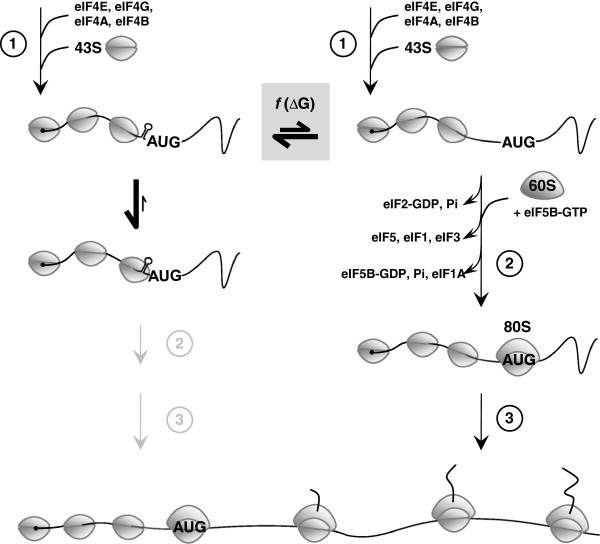
Effects of small, ‘local’, GC-rich mRNA stem-loops on the yeast 43S PIC. Protein translation in eukaryotes starts (1) with the binding of the eukaryotic initiation factor 4F (eIF4F = eIF4E and eIF4G) to the 5′ cap (5′ m7G; black dot) of the mature mRNA. eIF4A together with eIF4B are thought to unwind secondary structure in an ATP-dependent fashion close to the 5′ cap to allow access for the 43S PIC (small grey ovals). The 43S PIC consists of the 40S ribosomal subunit to which eIF1, 1A, 2 (bound to GTP), 3 and 5 and tRNAMet are bound. After attachment of the 43S PIC next to the 5′ cap region AUG start-codon scanning proceeds. Recognition of the AUG start-codon (2) induces GTP hydrolysis and the release of eIF2, GDP, and Pi, which is followed by the eIF5B-GTP catalyzed joining of the 60S subunit (large grey oval) and the displacement of eIF5, eIF1 and eIF3 followed by hydrolysis of eIF5B-GTP and the release of eIF5B-GDP and eIF1A leading to the production of an 80S initiation complex competent for elongation (3) [36,37]. Small, ‘local’, GC-rich mRNA stem-loops 5′ proximal to the AUG start codon inhibit AUG start-codon scanning of the yeast 43S PIC by providing a physical barrier to the advancing complex and possibly get trapped inside the complex (center left; [36,40]). The ratio between mRNA molecules that contain a GC-rich mRNA stem-loop (left side) in front of the advancing 43S PIC and those that don’t (right side) may be a function of the thermodynamic stability of stem-loops and determine the amount of protein that can be translated leading to a biphasic polysome distribution (the majority of mRNA molecules bound to 43S PIC (center left) and a small pool of mRNA that is inversely proportional to the stability of the stem-loop and heavily loaded with actively translating 80S ribosomes (bottom)).